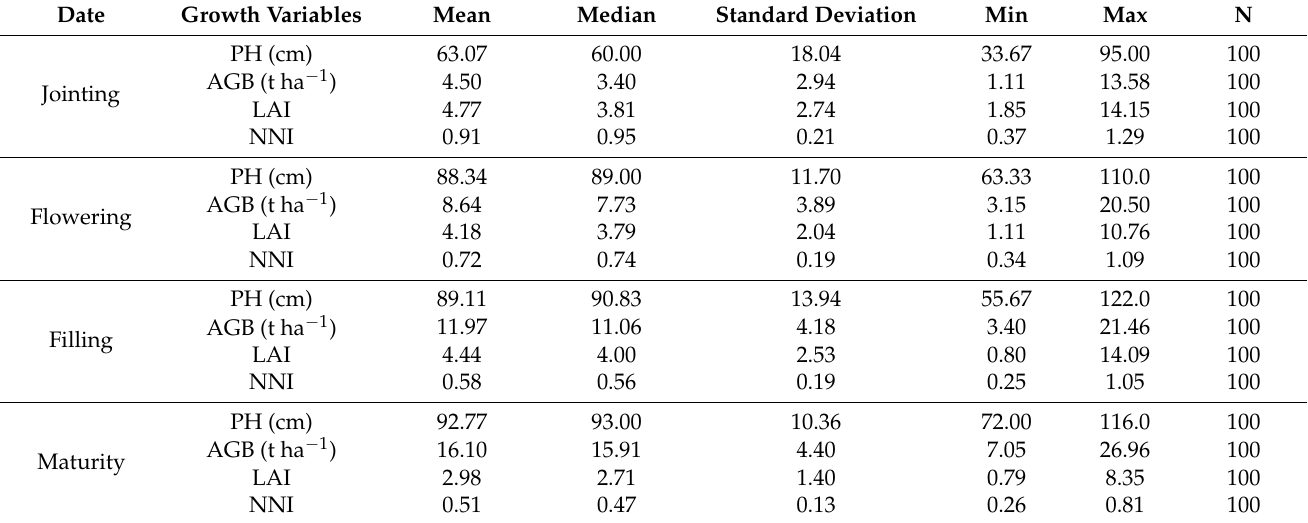
Table 2. Descriptive statistics of PH, AGB, LAI, and NNI at different stages of